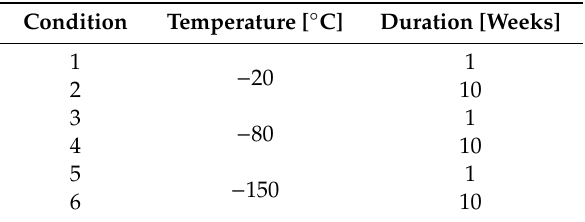
Table 1. Investigated storage